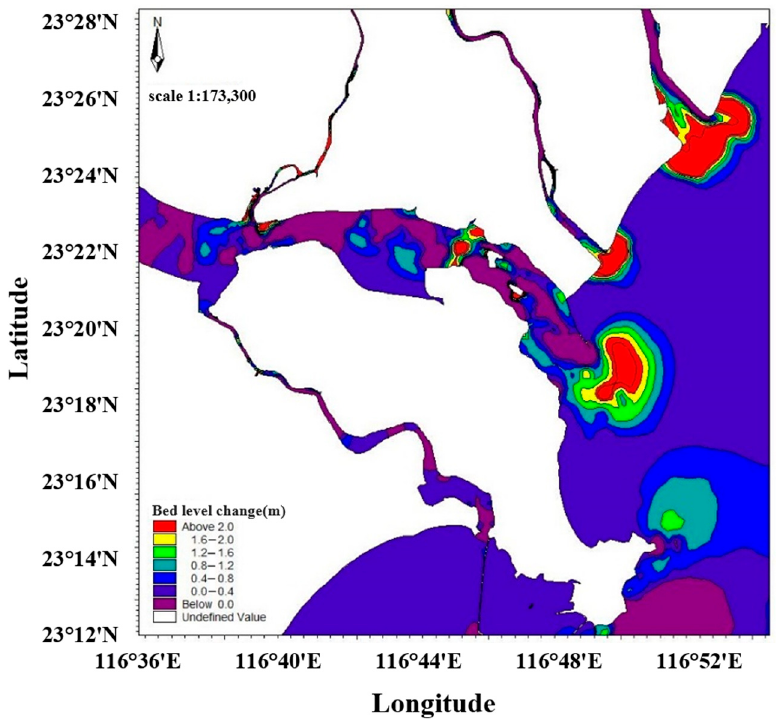
Figure 13. Overall siltation in the study